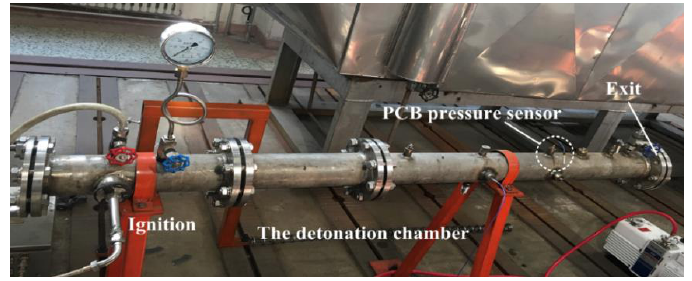
Figure 3. Schematic of the experience model.